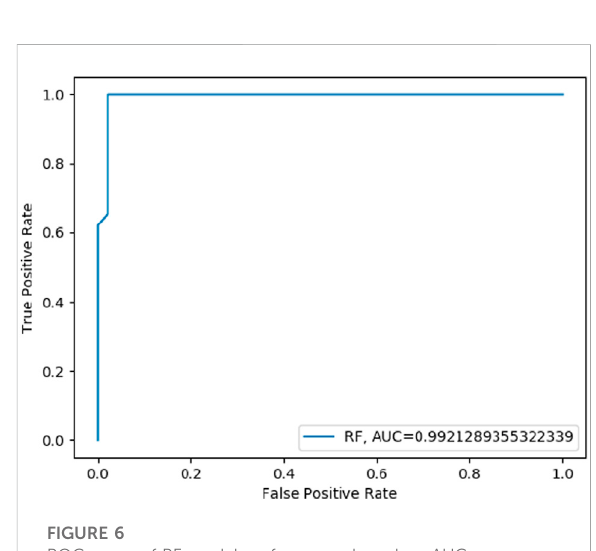
FIGURE 6 ROC curve of RF model performance based on AUC